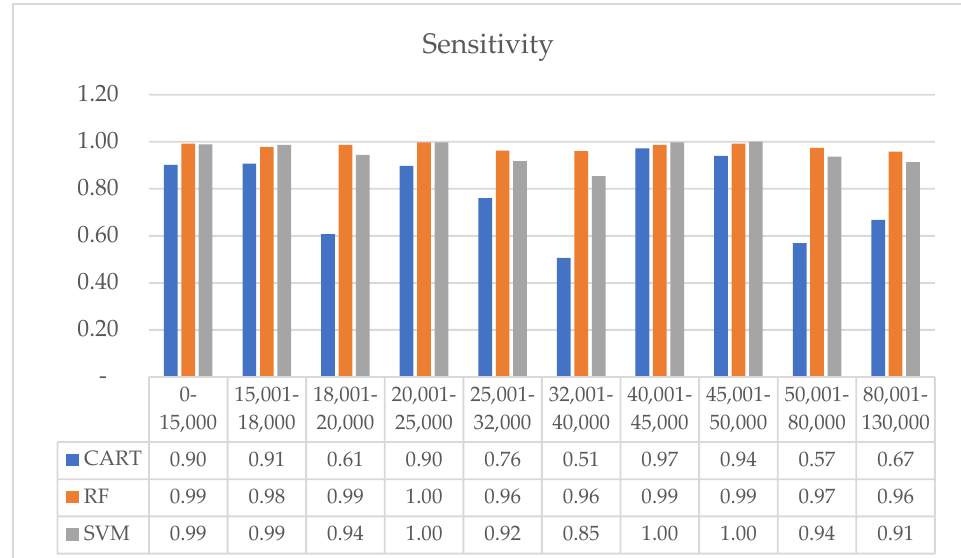
Figure 7. Sensitivity values distribution of all models.